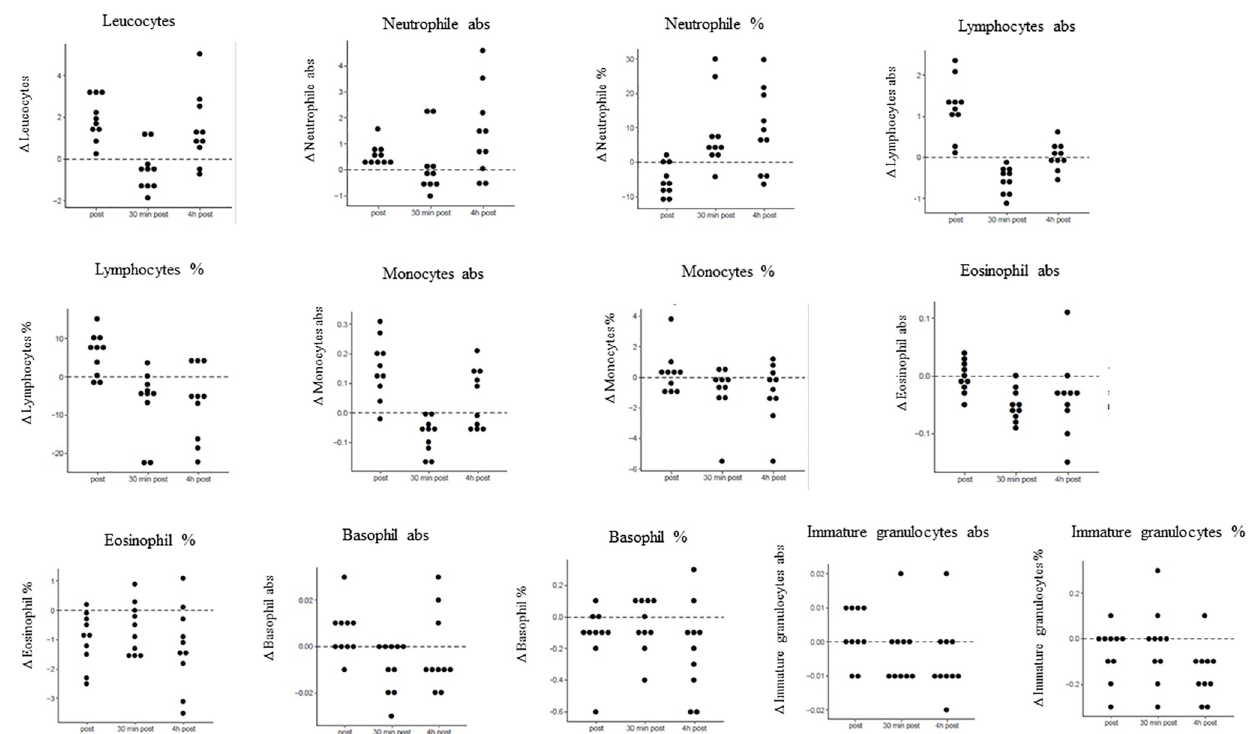
Fig 2. Concentration changes of white blood cell parameters compared to baseline. Displayed are concentration changes at the three different time points post apnea, 30 min and 4 h post apnea compared to baseline values for white blood cell parameters. https://doi.org/10.1371/journal.pone.0237673.g002 Table 5. Mean values, standard deviations and p -values at four different time points (baseline concentrations, immediately post apnea, 0.5 h and 4 h after apnea) for thrombocytes and mean platelet volume. Mean [ ± SD] p -value Baseline concentration [ ± SD] Post apnea [ ± SD] 4 h post apnea [ ± SD] Thrombocytes G/l 0.0003 Mean values, standard deviations (SD) and p -values at the four time points baseline concentrations, immediately post apnea, 0.5 h and 4 h after apnea for thrombocytes and mean platelet volume. Significant p -values are marked in bold.